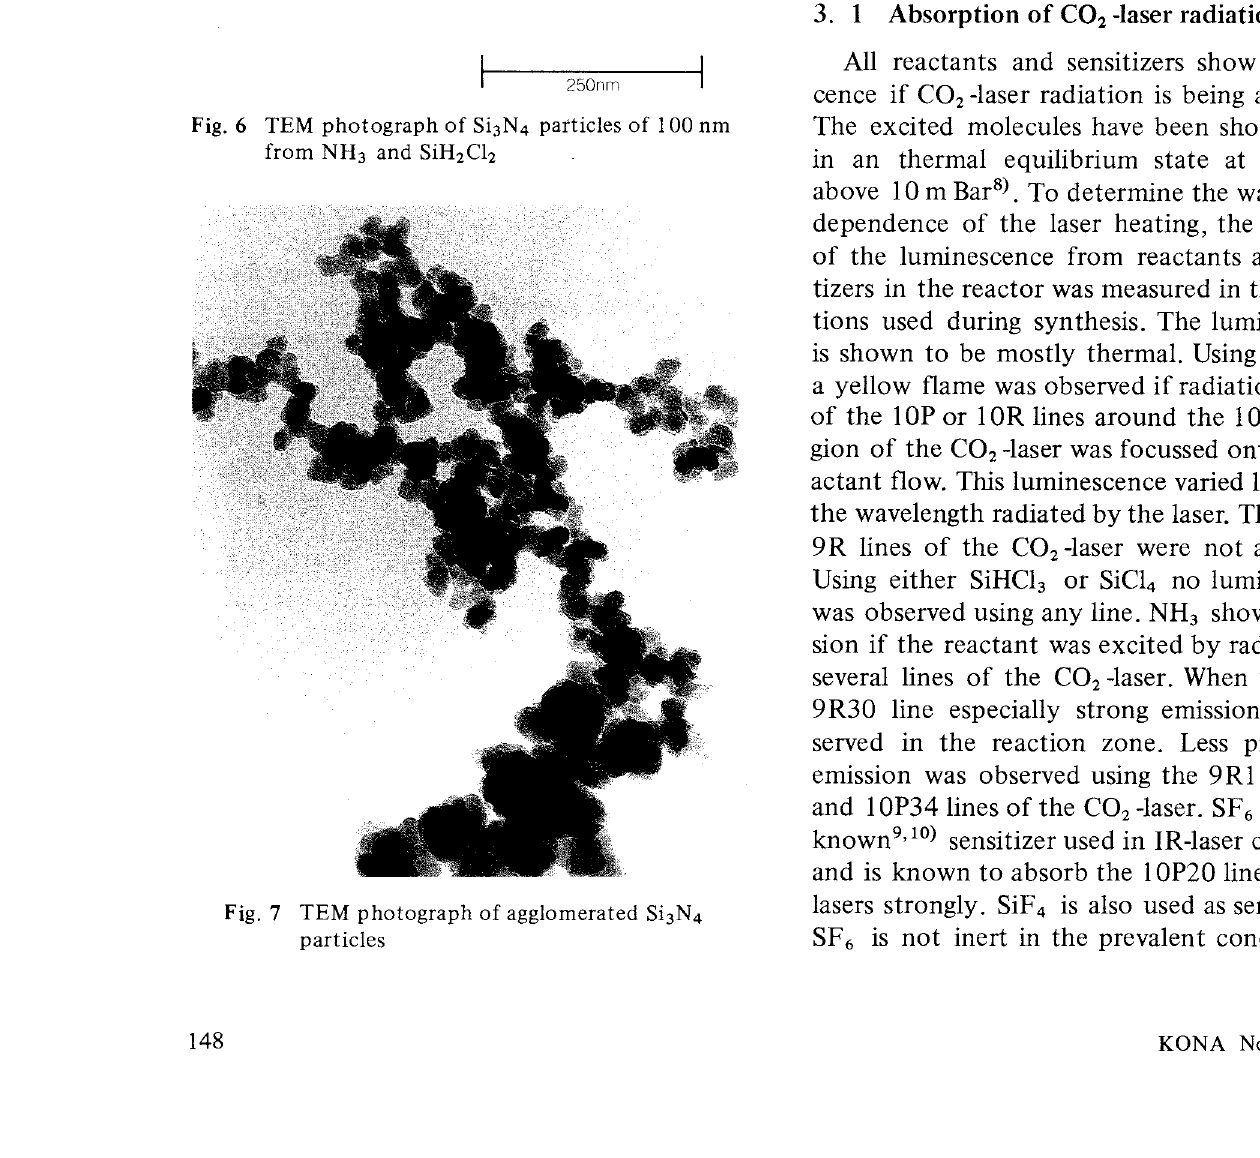
Fig. 6 TEM photograph of Si 3 N 4 particles of I 00 nm